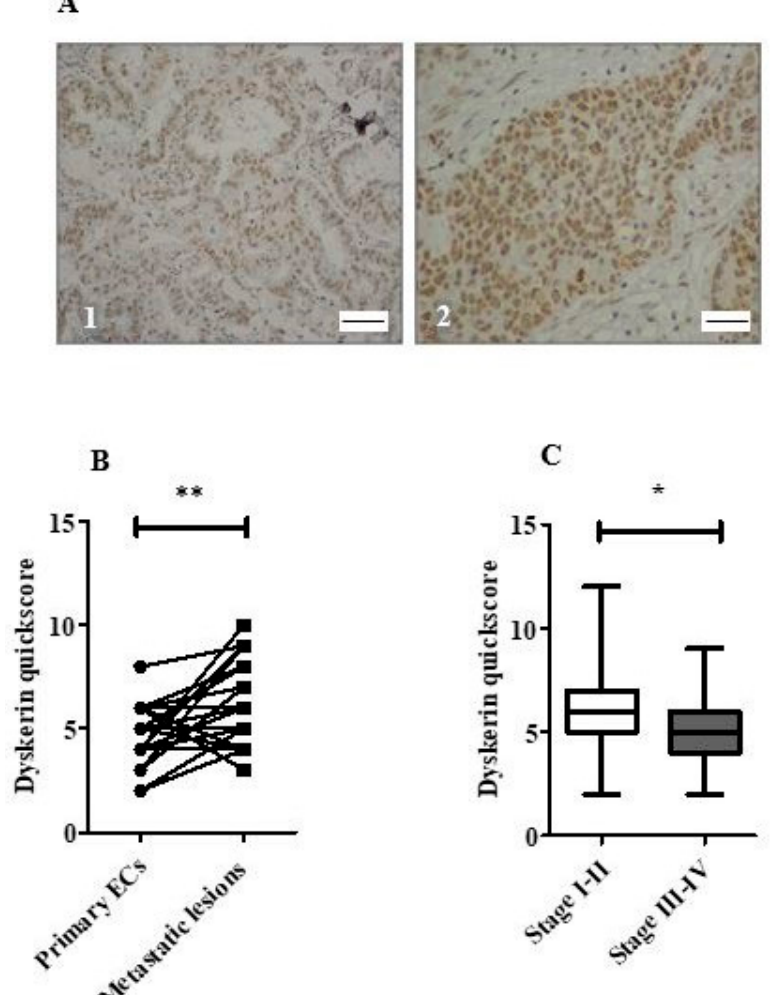
Figure 4. Dyskerin immunostaining in endometrial cancers. ( A ) Representative microphotographs illustrating dyskerin immunohistochemical staining in primary endometrial cancer (EC) ( 1 ) and matched metastatic lesion ( 2 ). Positive staining appears in brown. Magnification 400×, Scale bar 50 μ m ( B ) Difference in dyskerin immunoscores in primary EC samples versus matched metastatic lesions ( n = 30) each, ** p < 0.01. ( C ) Difference in dyskerin immunoscores between early-stage ECs